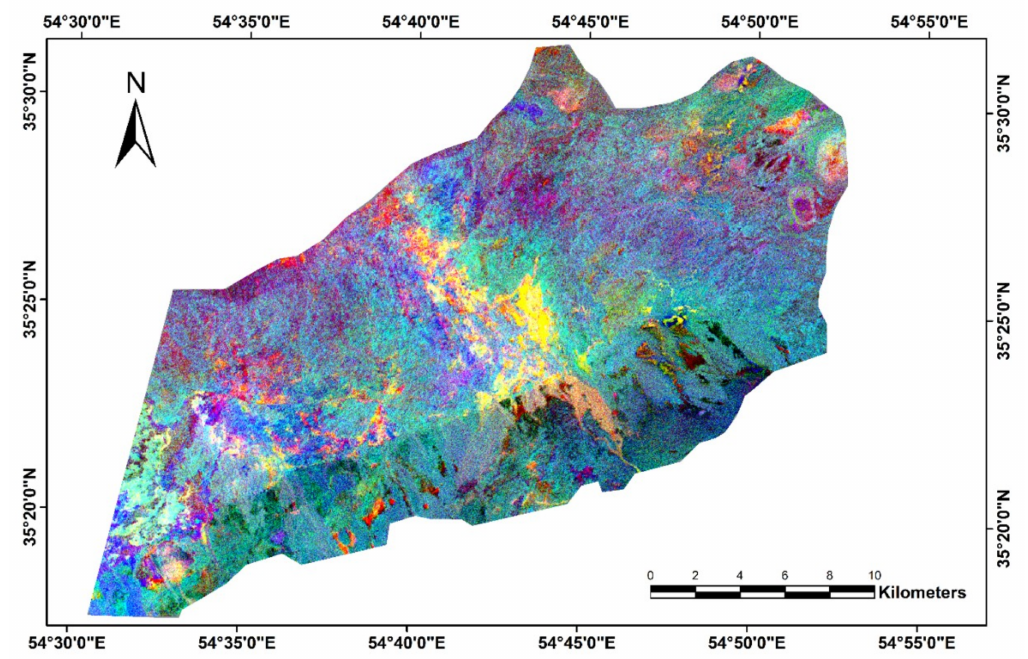
Figure 5. RGB false color composite of the SPC3 of argillic alteration (R), SPC3 of phyllic alteration (G), and SPC3 of propylitic alteration (B) images covering the study